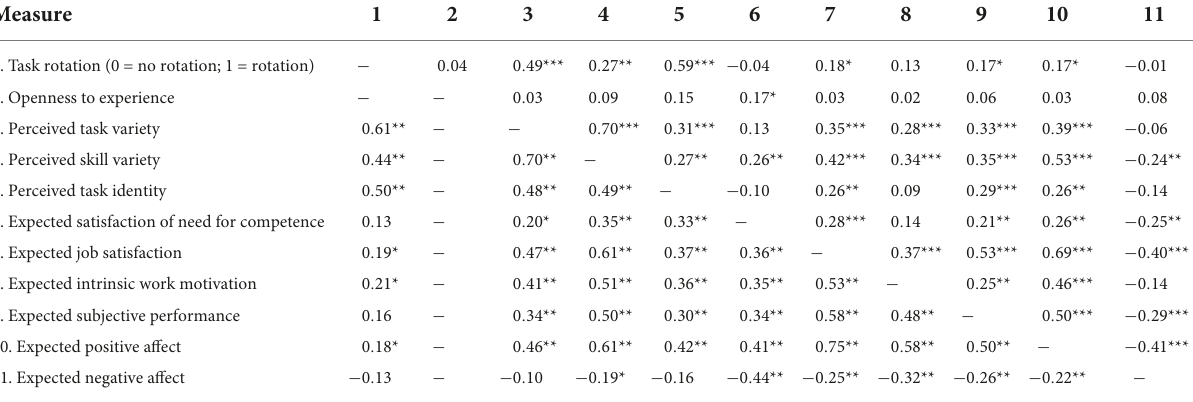
TABLE 2 Zero-order correlations of study variables.